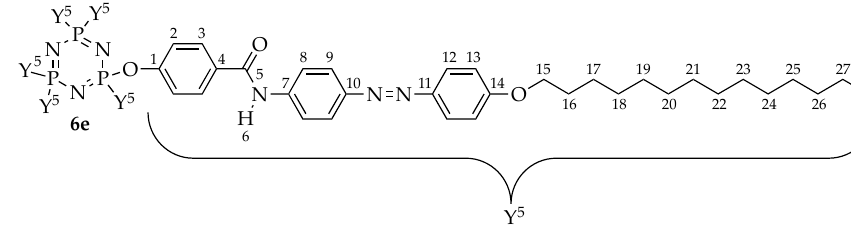
Figure 4. Structure of compound 6e with complete atomic numbering.